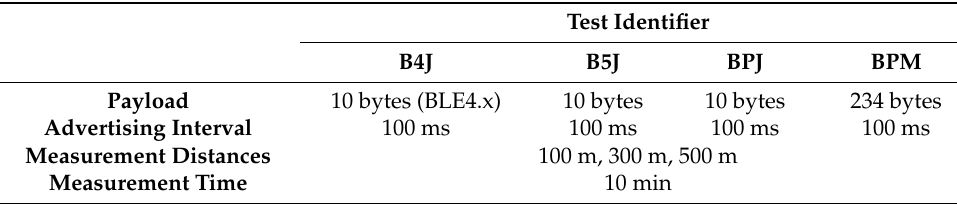
Table 6. Configuration tests for I2V coexistence scenario.